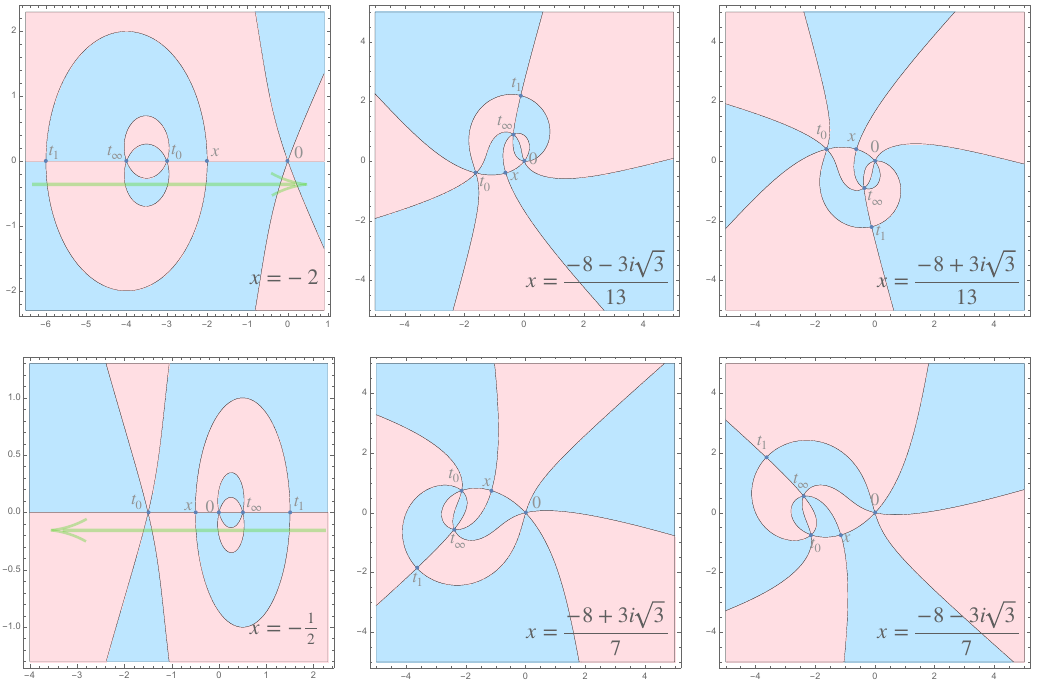
Figure 3 . Covering surfaces for n 1 = n 2 = 3 . In each panel, the horizontal axis is Re( t ) and the vertical axis Im( t ) . Blue patches are the preimages of the upper-half plane Im( z ) > 0 , and pink patches the preimages of the lower-half plane Im( z ) < 0 , under the covering map (3.17). The positions of the ramification points t 0 , t 1 , t ∞ depend on the position of the ramification point x according to (3.18). The 6 panels correspond to the 6 solutions x a of eq. (3.20) for z ( x ) = v = 1